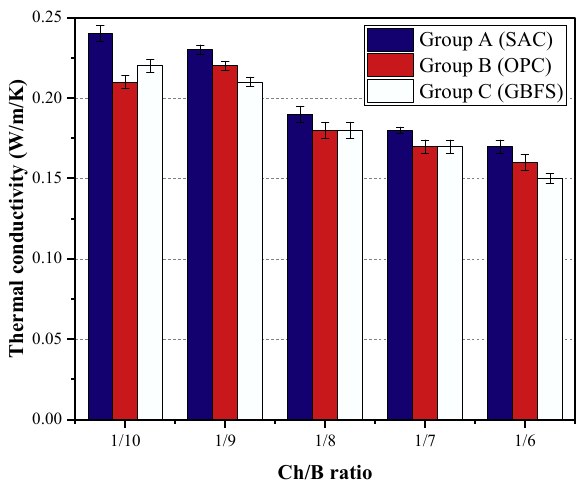
Figure 8. Thermal conductivity of the different groups.